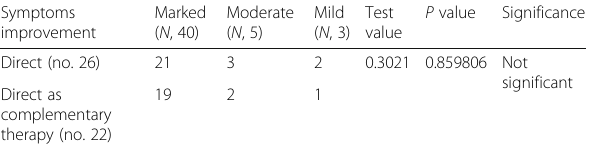
Table 9 The correlation between the method of injection either direct USGFS alone or in combination with other methods and the symptomatic correlation Symptoms improvement